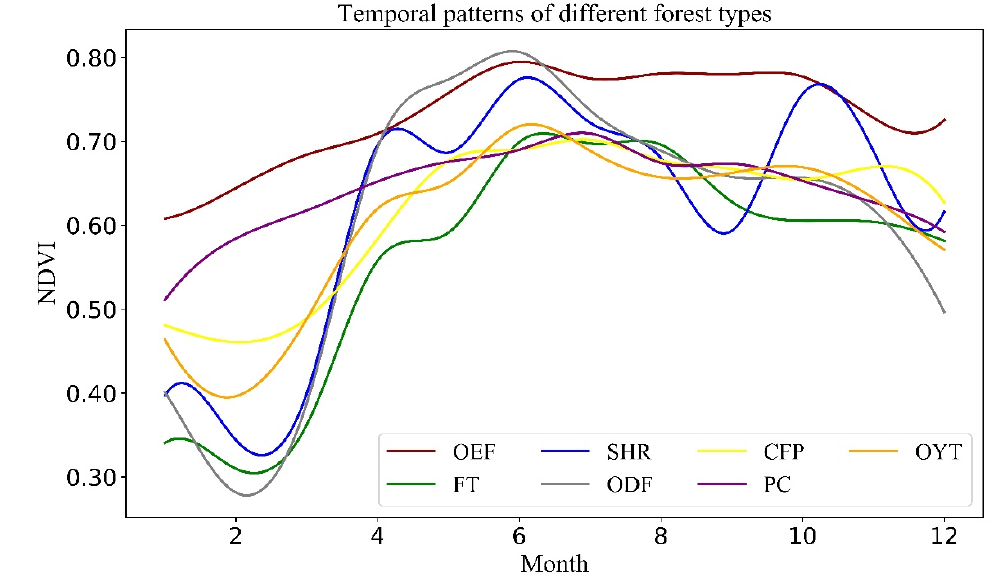
Figure 7. Temporal patterns of NDVI for all classes mapped, where OEF represents other evergreen forests, ODF represents other deciduous forests, SHR represents shrubs, FT represents fruit trees, CFP represent Chinese fir plantations, PC represents pine and cypress trees, and OYT represents oil-yielding trees.